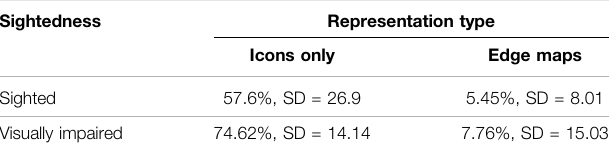
TABLE 1 | Percentages and Standard Deviationsof correctly identi fi ed objects for each representation type for sighted and visually impaired individuals. Sightedness